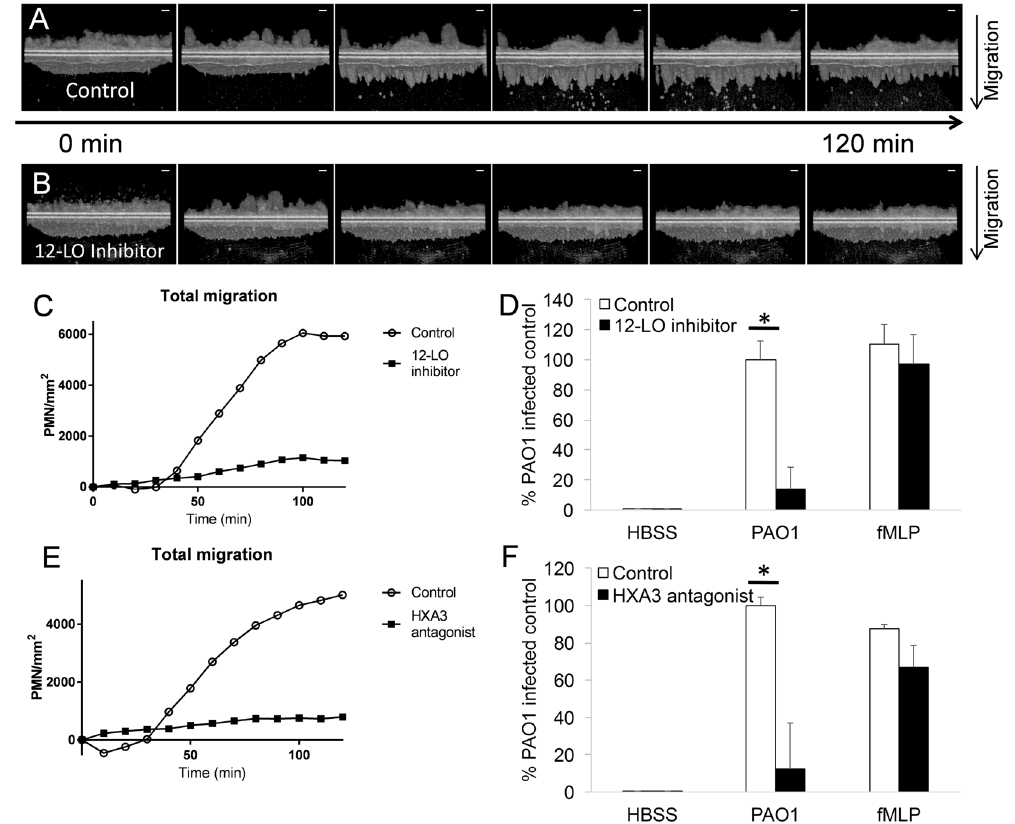
Figure 4. Inhibition of hepoxilin A3 reduces PAO1-induced neutrophil migration across human airway basal cell-derived epithelial barriers. Time-lapse µ OCT images of neutrophil transepithelial migration following epithelial treatment with ( A ) vehicle control (DMSO 1:1000) or ( B ) CDC, a 12-LO inhibitor. ( C ) Neutrophil migration of single, representative experiment was quantified by µ OCT time course plot following epithelial treatment with 12-LO inhibitor CDC, or vehicle control (DMSO 1:1000). ( D ) Neutrophil migration was quantified using myeloperoxidase in response to PAO1 infection or an imposed gradient of fMLP following epithelial treatment with 12-LO inhibitor CDC, or vehicle control (DMSO 1:1000). Data displayed combined results from two internally controlled, independent experiments (PAO1 infection: n = 4 for each condition). ( E ) Time course plot comparison of single, representative µ OCT imaging quantifies migration visualized following epithelial treatment with HxA3 antagonist or control (HBSS) at the apical surface. ( F ) Neutrophil migration in response to epithelial infection with PAO1 or an imposed gradient of fMLP in the presence or absence of HxA3 antagonist was quantified by myeloperoxidase assay. Data combined results from two internally controlled, independent experiments (PAO1 infection: n = 4 for each condition). µ OCT images are representative of at least 2 separate